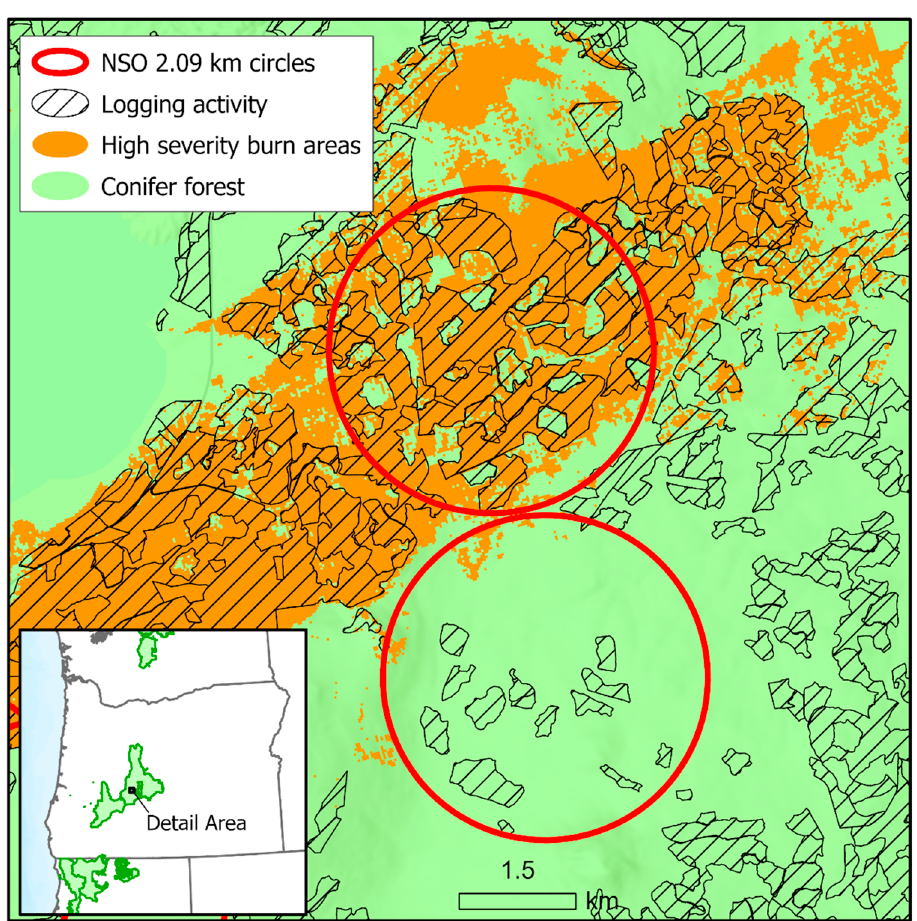
Figure 3. Examples of two Northern Spotted Owl provincial home range areas and the intersecting conifer forest, severe fire, and logging covariates.